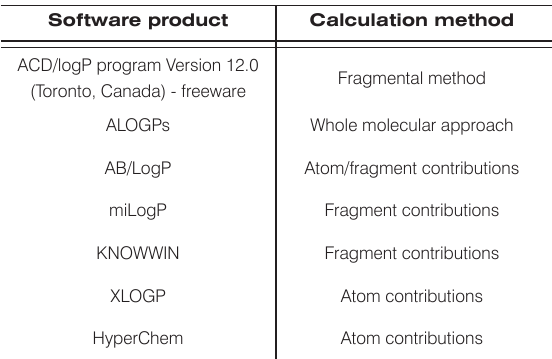
Table 1. Classification of software